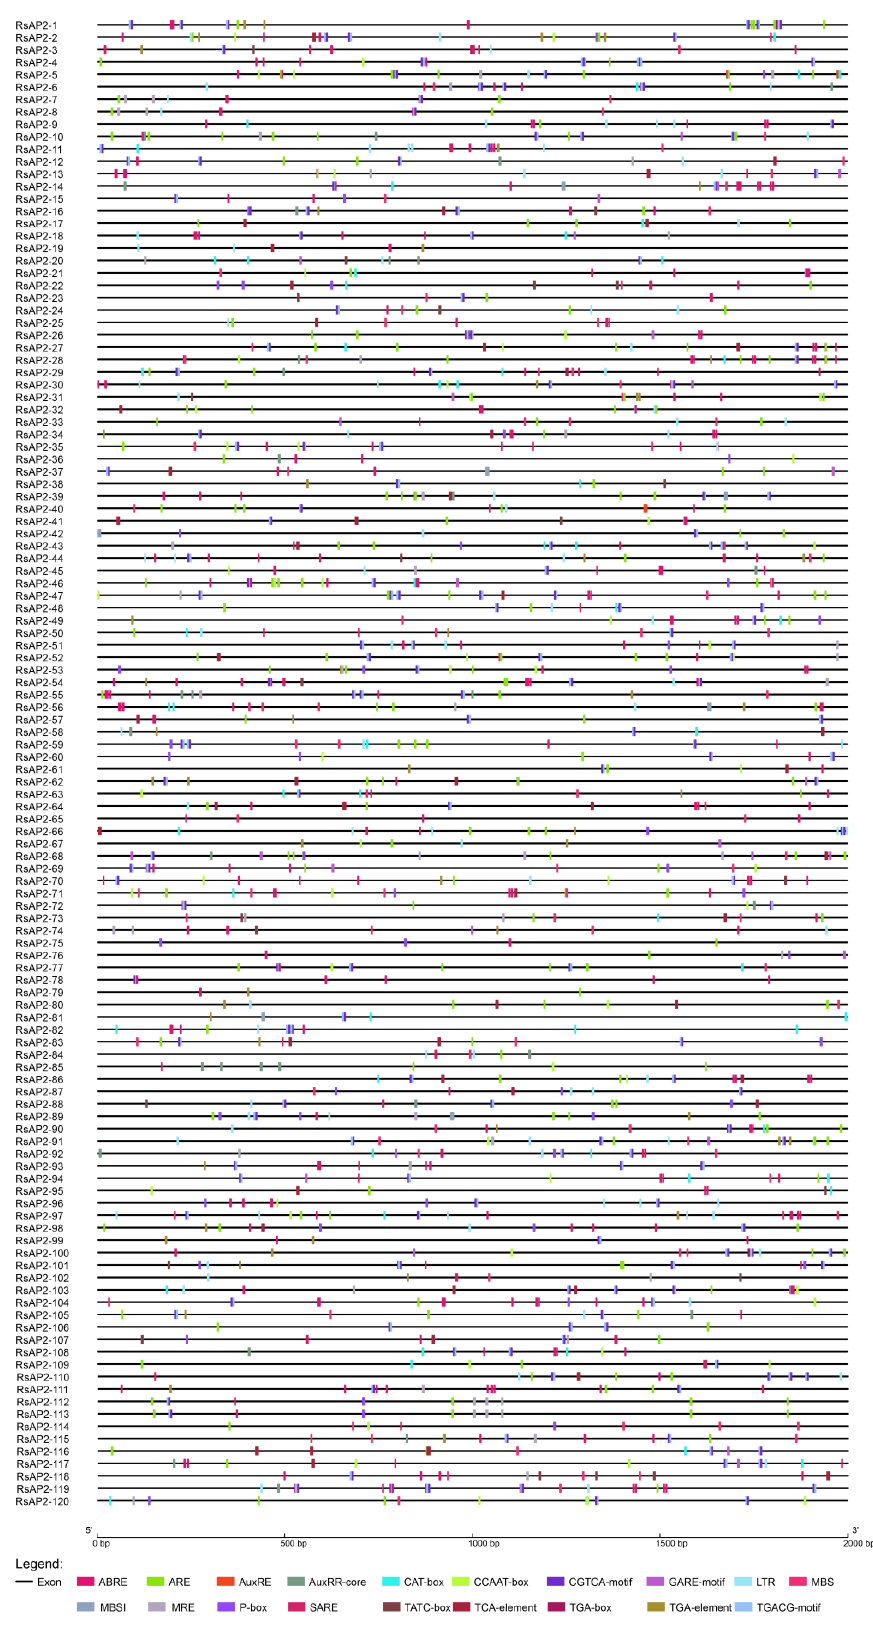
Figure 6. Cis-acting elements in RsAP2 promoters.